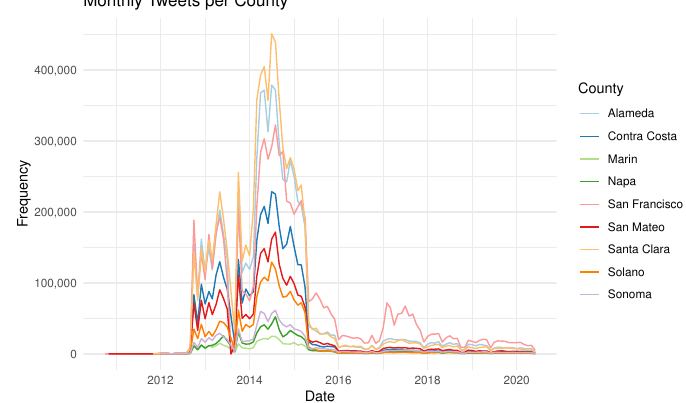
Figure 2. Tweets per Month and County for the entire observation period.